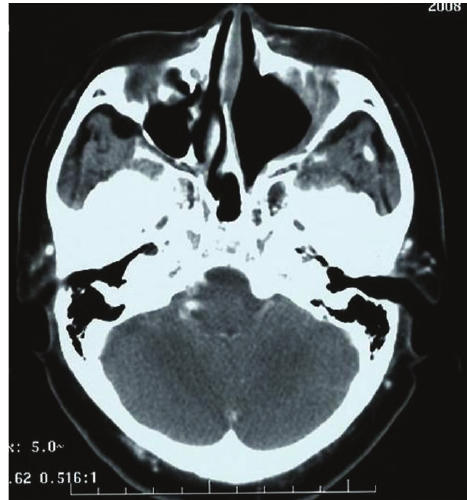
Figure 4: Soft tissue shadows remained. No cancer cells were observed in biopsy samples from three locations.